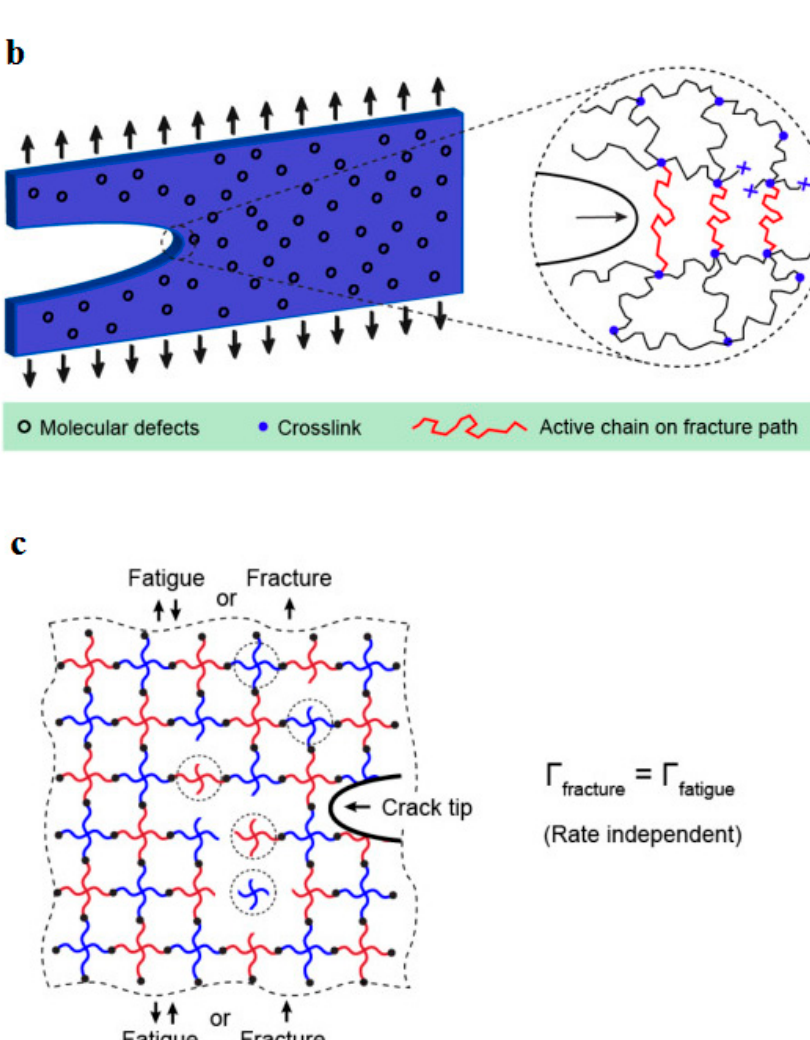
Figure 31. ( a ) Schematic representation of ideal polymer networks involving the imperfection of dangling chains (adapted with permission from Ref. [107]. Copyright © 2021 Elsevier Ltd.). ( b ) Illustration of defect-network fracture model (adapted with permission from Ref. [108]. Copyright © 2020 American Physical Society). ( c ) Schematic illustration of the equality of fracture toughness and fatigue threshold of the ideal polymer networks (adapted with permission from Ref. [107]. Copyright © 2021 Elsevier